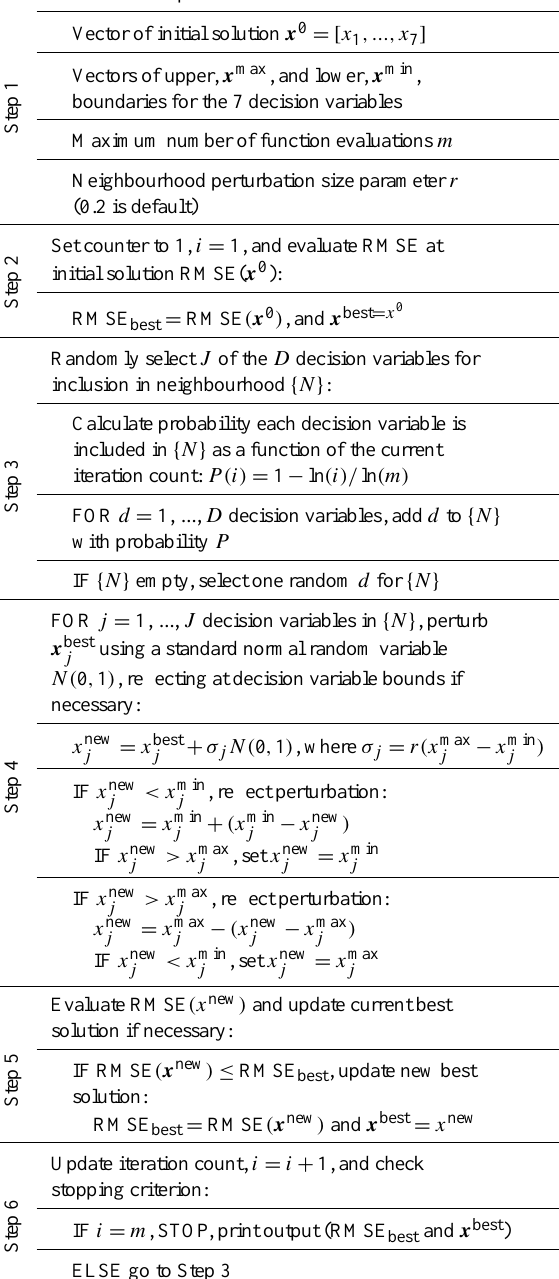
Table 2. Working steps of the implemented DDS algorithm in PRACTISE (adapted from Tolson and Shoemaker, 2007). Table 3. Vectors of the DDS optimisation example with 3000 iter- ations: x 0 , x max , x min and x best . The values are in m except noted otherwise. x max of C is set to the values of x 0 as the UFS building